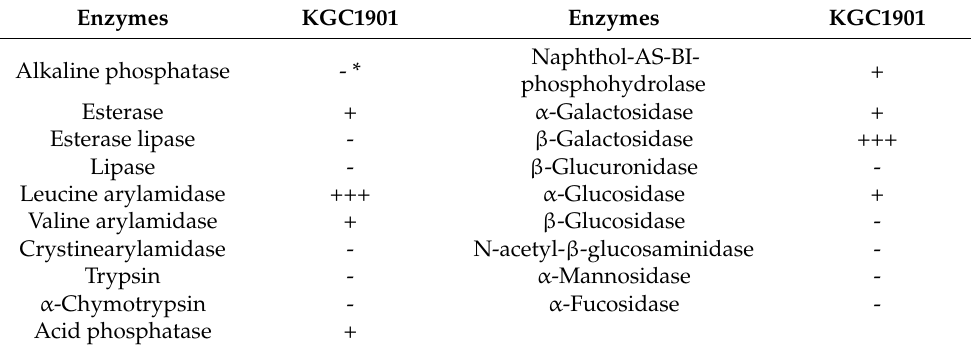
Table 3. Enzymatic activities of L. reuteri